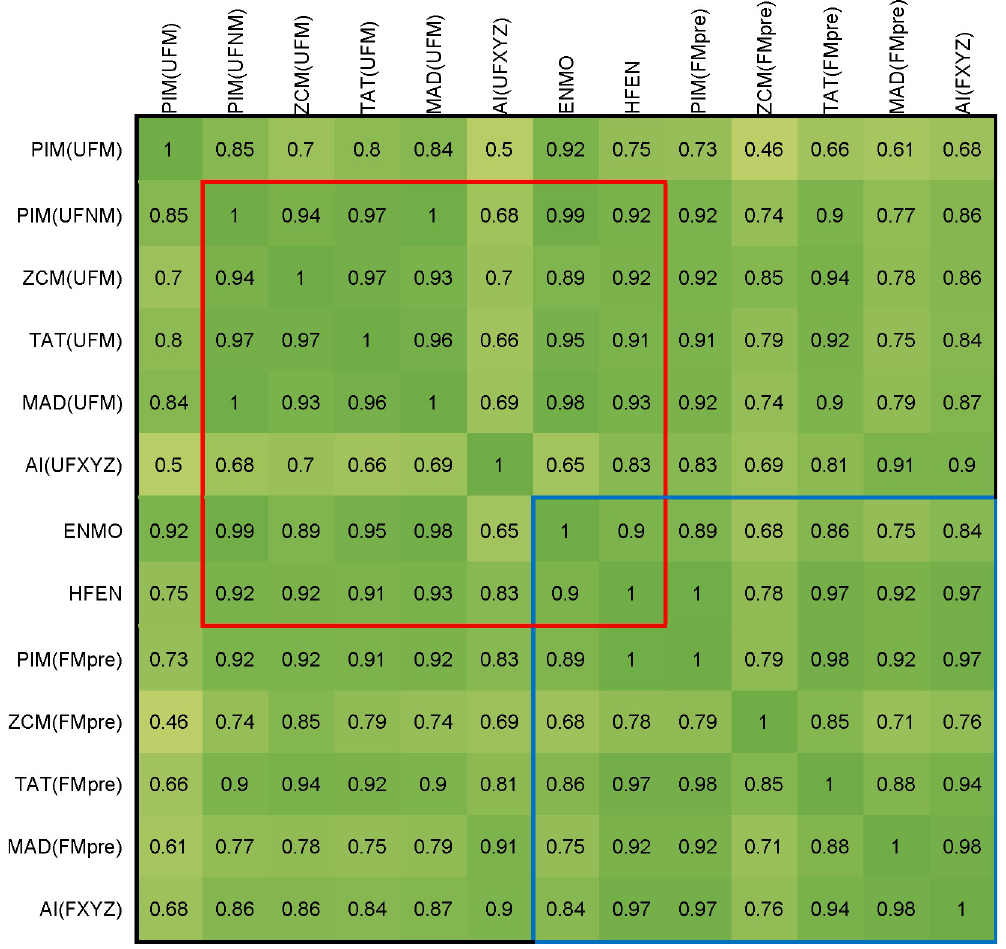
Fig 8. Correlation between activity signals calculated from raw (UFM, UFXYZ) and filtered datasets (FMpre, FXYZ). In addition, we included the PIM metric applied on the UFNM dataset, too. The Pearson’s correlation coefficients are calculated by 42 measurements, and their means are represented. Cells in the red square indicate correlations between activity signals calculated by the unfiltered datasets, and cells in the blue square include correlations between activity signals calculated by the filtered datasets. Since our goal is to compare all 7 metrics, but no filtering is possible in the case of ENMO, and as HFEN demands a specially filtered dataset, we included them in both